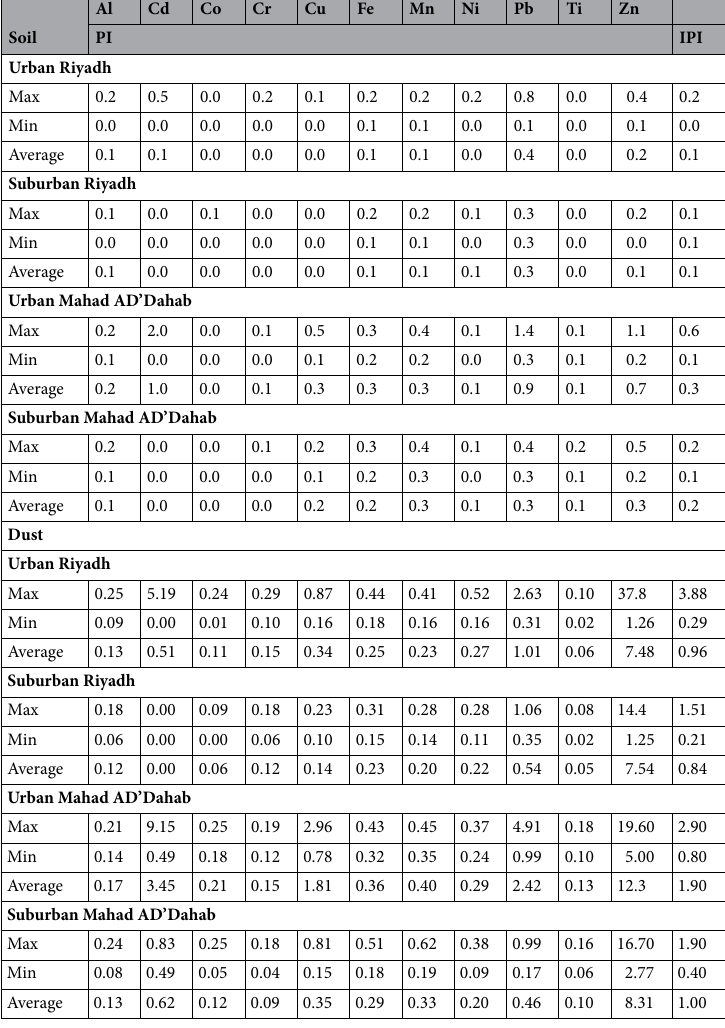
Pollution and ecological indices and sources of HMs in soil and dust samples. The calculated data pertaining to the PI, Igeo, EF, Ei, and RI parameters for all HMs in soil and dust samples from urban and suburban areas of Riyadh and Mahad AD’Dahab are presented in Tables 3, 4, 5 and 6. It was generally observed that the values of pollution and ecological indices of all the analyzed HMs were higher in dust samples vs. soil samples. The calculated data of PI for all HMs of soil and dust samples from urban and suburban areas of Riyadh and Mahad AD’Dahab are presented in Table 3. The results showed that all soil samples collected at Riyadh sites had maximum, minimum, and mean PI values < 1, indicating a low level of pollution with HMs 54 . However, the soil samples collected at urban sites of Mahad AD’Dahab had maximum PI values of 2.0 for Cd, 1.4 for Pb, and 1.1 for Zn, indicating a moderate level of pollution with these HMs. For dust samples, compared with soil sam- ples, the average PI values for Zn were higher than 3, suggesting a high pollution level (Table 3). The urban dust samples collected at Mahad AD’Dahab showed moderate pollution levels regarding Cu (mean PI value = 1.81) and Pb (mean PI value = 2.42), and high pollution levels regarding Cd (mean PI value = 3.45) and Zn (mean PI value = 12.0). Similarly, dust samples collected at Riyadh had average PI values of 7.48 and 7.54 for Zn in urban and suburban areas, respectively; therefore, they exhibited a high pollution level. The IPI values in soil samples collected in the Riyadh and Mahad AD’Dahab areas were < 1, indicating a low level of pollution with HMs. However, based on the maximal values of IPI in samples collected from urban areas of Riyadh and Mahad AD’Dahab, the dust samples were moderately and highly polluted, respectively. Table 4 shows the values of the geo-accumulation index of the soil and dust samples collected at the Riyadh and Mahad AD’Dahab sites. The results indicate that all soil and dust samples were unpolluted, with the excep- tion of the presence of Zn in the dust samples. In the urban Riyadh area, the Igeo values of Zn ranged from 0.94 to 3.53, suggesting moderate or strong pollution levels. However, the Igeo values of Zn in the dust samples collected at the two sites of the Riyadh suburban area ranged from 1.75 (S18) to 2.35 (S19), suggesting moderate